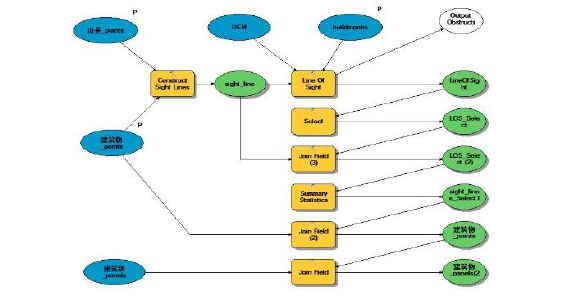
Figure 3. the GP Model of Landscape Analysis Created by